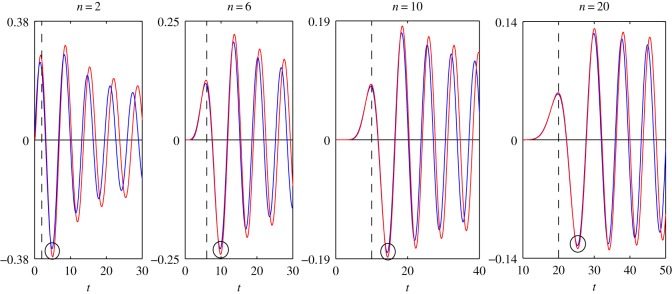
Plots of the functions: J′n(t)—blue line; F2(n, t)—red line.